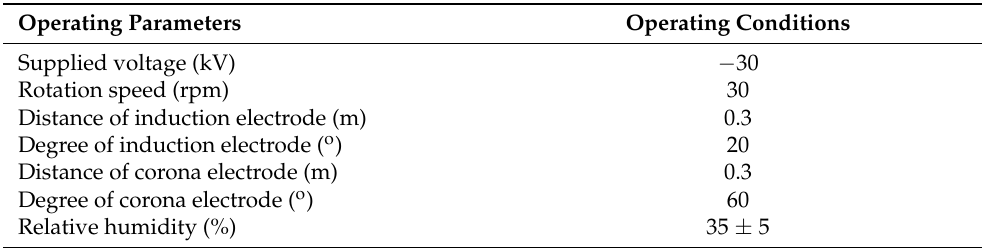
Table 1. Operating parameters and conditions of corona discharge electrostatic separation for recycling copper from waste PCB